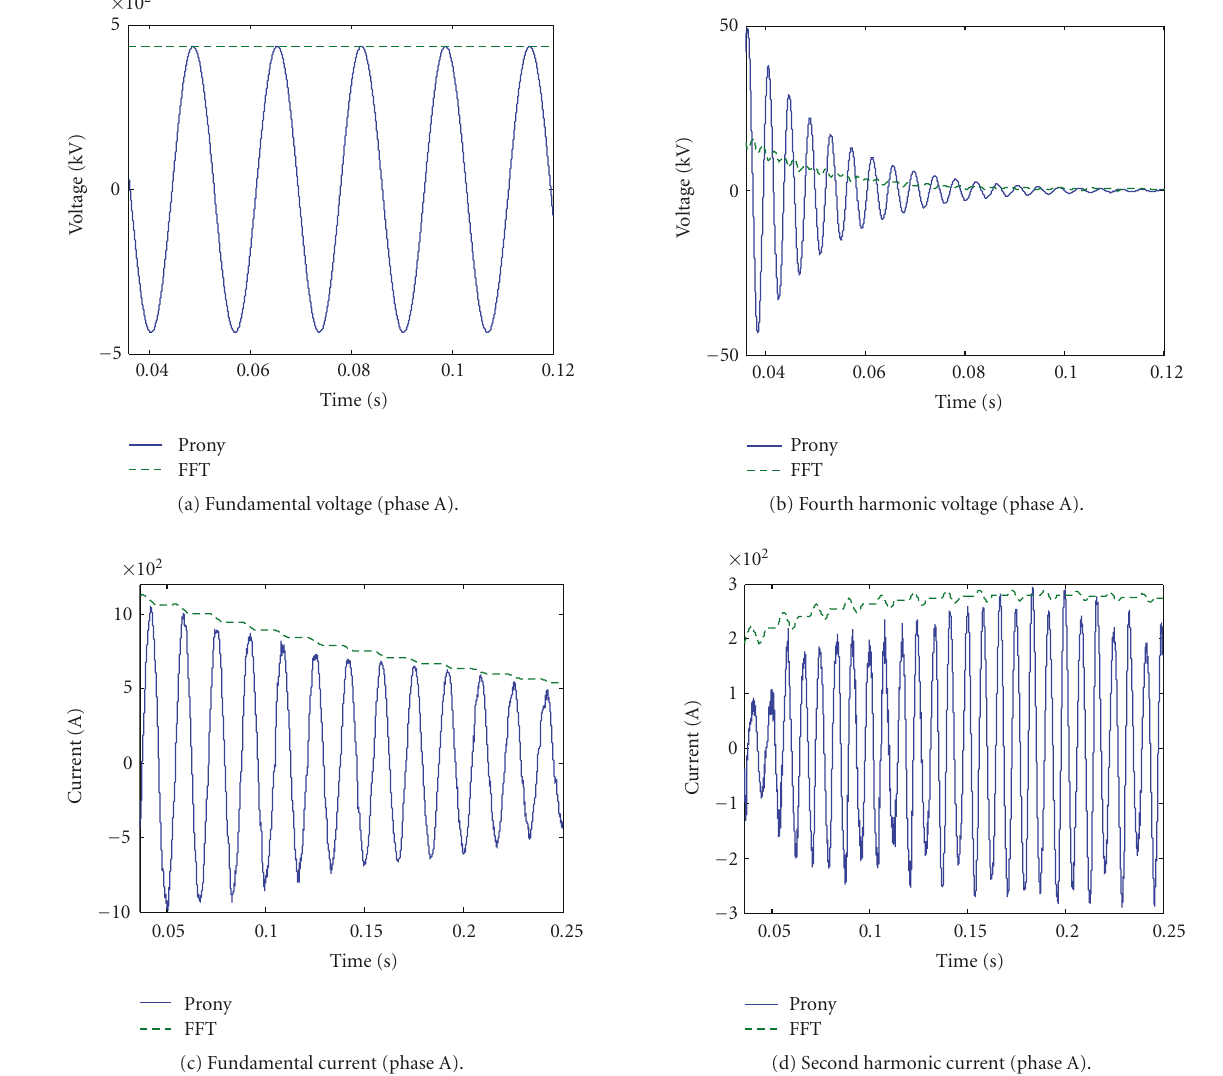
Figure 3: Prony and FFT results of case